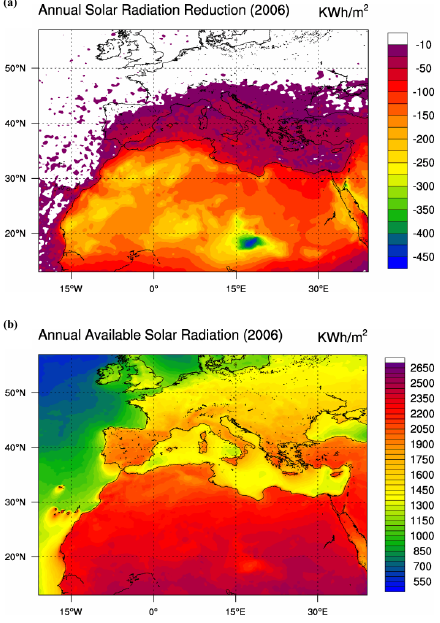
Fig. 10. Total reduction of the incoming solar radiation (integrated hourly throughout the year) for the year 2006 due to the scattering and absorption of desert dust particles (a) and the total available solar radiation for the same year (b)